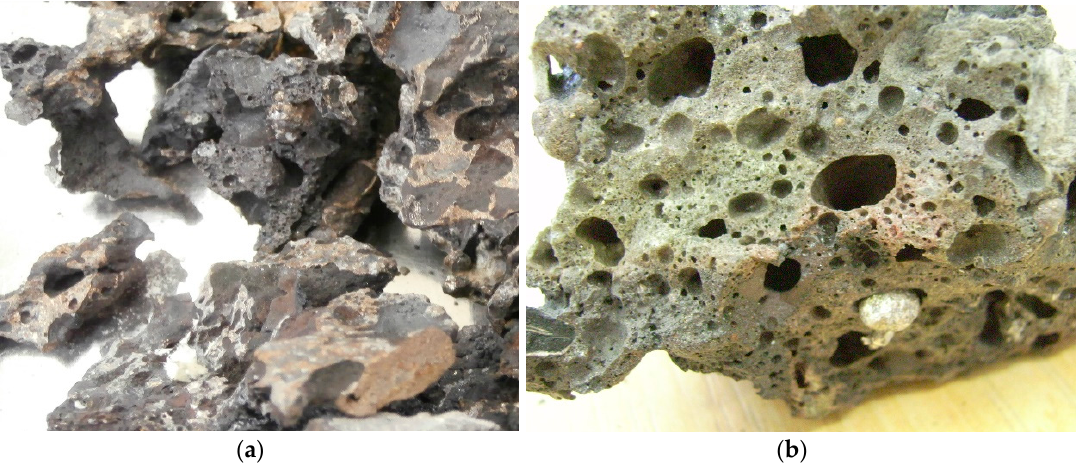
Figure 6. Photograph of separated products—metals ( a ); and slag ( b ).